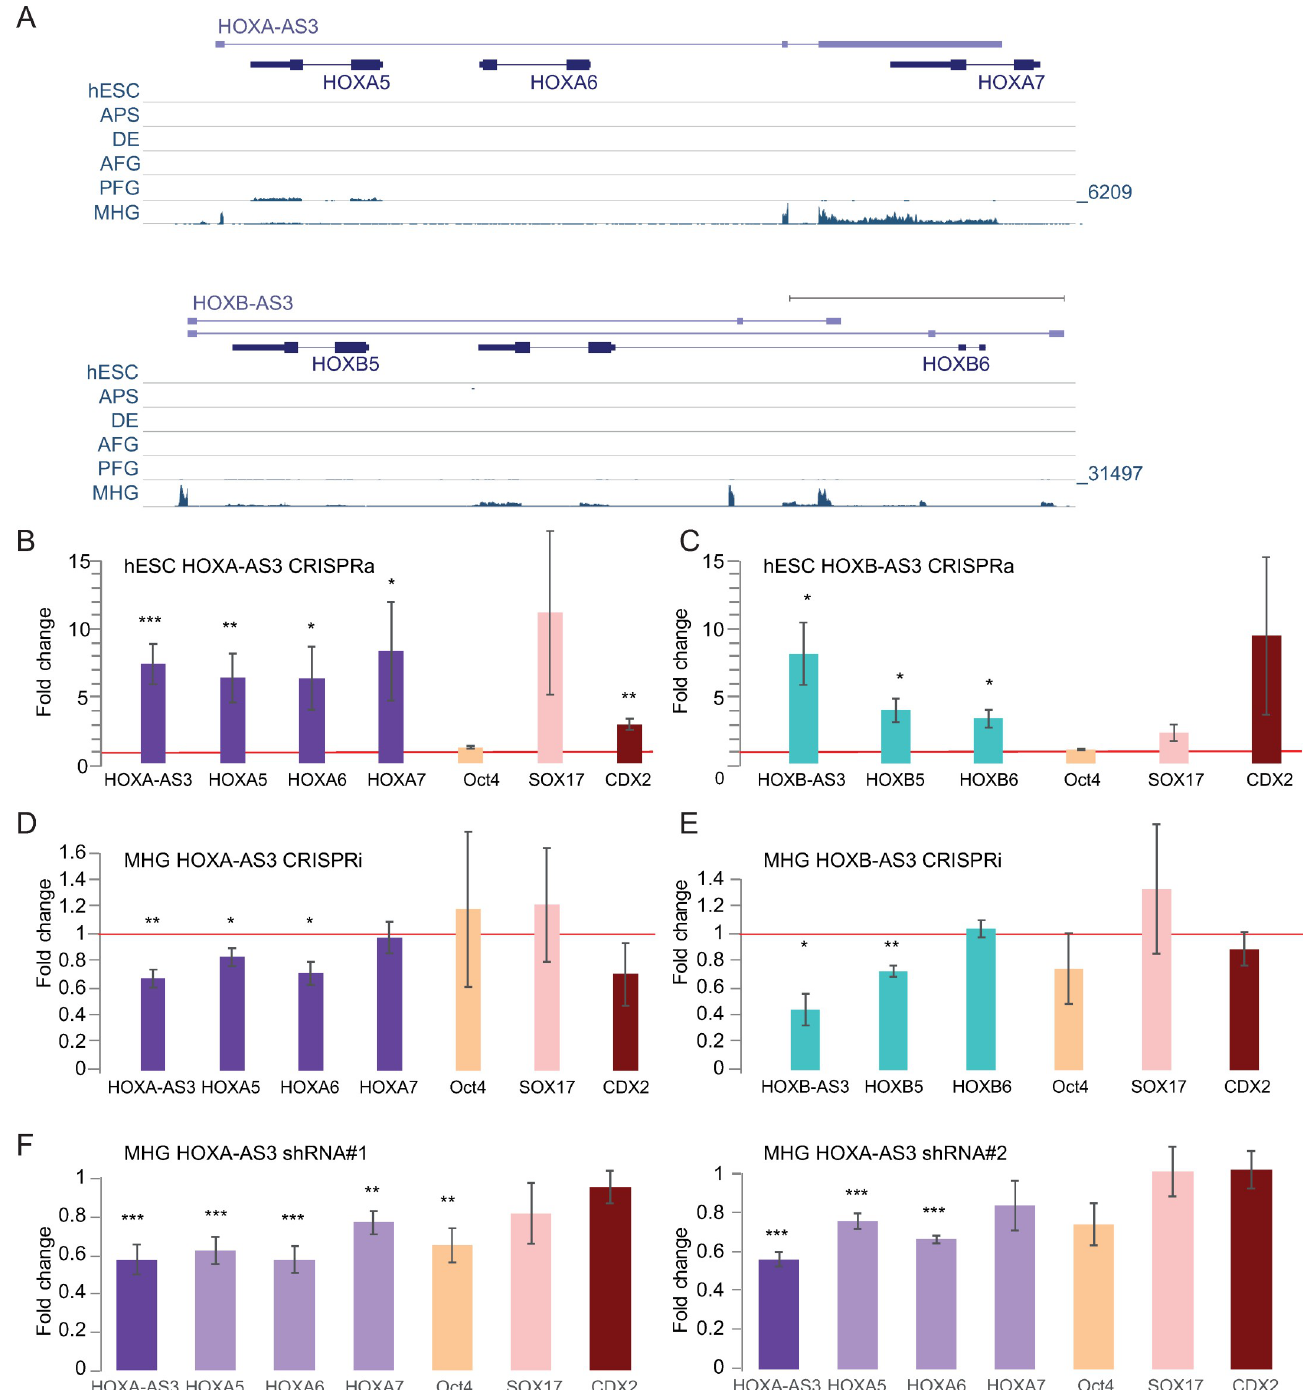
Fig 7. Function of HOXA-AS3 and HOXB-AS3 during endodermal differentiation of hESCs. (A) Read coverage in RNA-seq data from [38] for shown parts of the HOXA (top) and HOXB (bottom) clusters. In each cluster all the tracks are normalized together. (B-C) Expression levels estimated by qRT-PCR for the indicated genes in hESCs following CRISPRa-mediated 48h activation of HOXA-AS3 (n = 7/4) ( B ) and HOXB-AS3 (n = 3) ( C ). ( D-E ). Expression levels estimated by qRT-PCR in MHG cells following CRISPRi-mediated repression of HOXA-AS3 (n = 3) ( D ) and HOXB-AS3 (n = 3) ( E ). (F) Changes in expression of the indicated genes following infection of hESCs with two separate HOXA-AS3 shRNAs, followed by differentiation to MHG. n = 6. � —P < 0.05; �� —P < 0.005; ��� — P < 0.005. Two sided t-test. Errors bars—SEM.